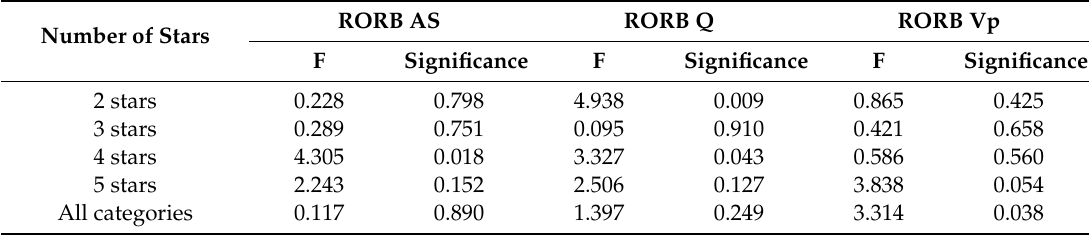
Table 4. One-way ANOVA of the rating of online reputation balance in the